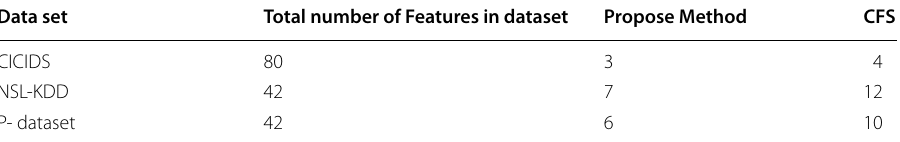
Table 23 Number of selected features, selected by different methods and proposed method on different datasets